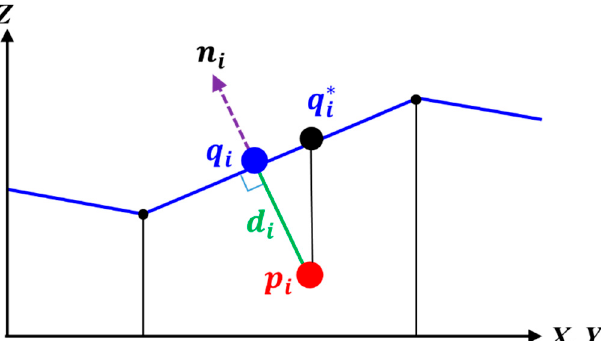
Figure 1. Distance measure of point-to-surface matching between ground control points (GCPs) ( 𝒑 (cid:3036) ) and surface Z(X,Y) of a digital elevation models (DEM).